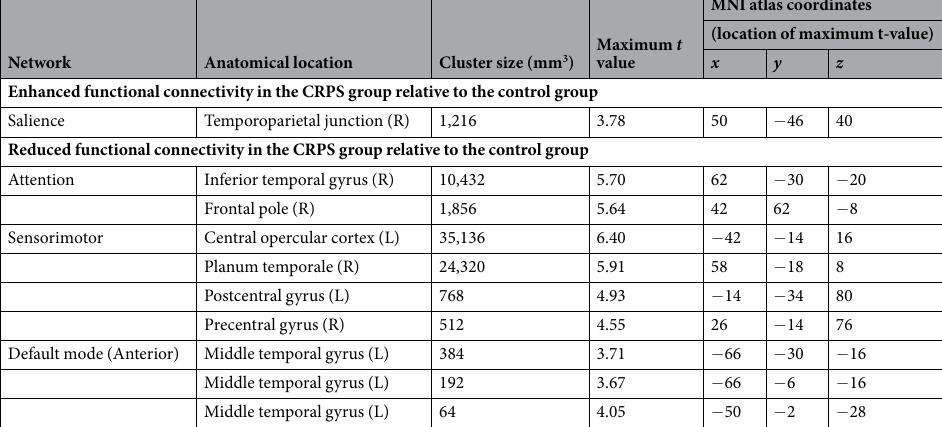
Table 1. Cluster information of voxel-wise functional connectivity alterations related to CRPS. The general linear model was used to define clusters of significant group effects (CRPS vs. control) on functional connectivity of each RSN of interest. The brain regions showing significant alterations in functional connectivity at a TFCE-corrected P < 0.05 were defined as clusters. Abbreviations: MNI, Montreal Neurological Institute; CRPS, chronic regional pain syndrome; RSN, resting state network; L, left; R, right; TFCE, threshold-free cluster